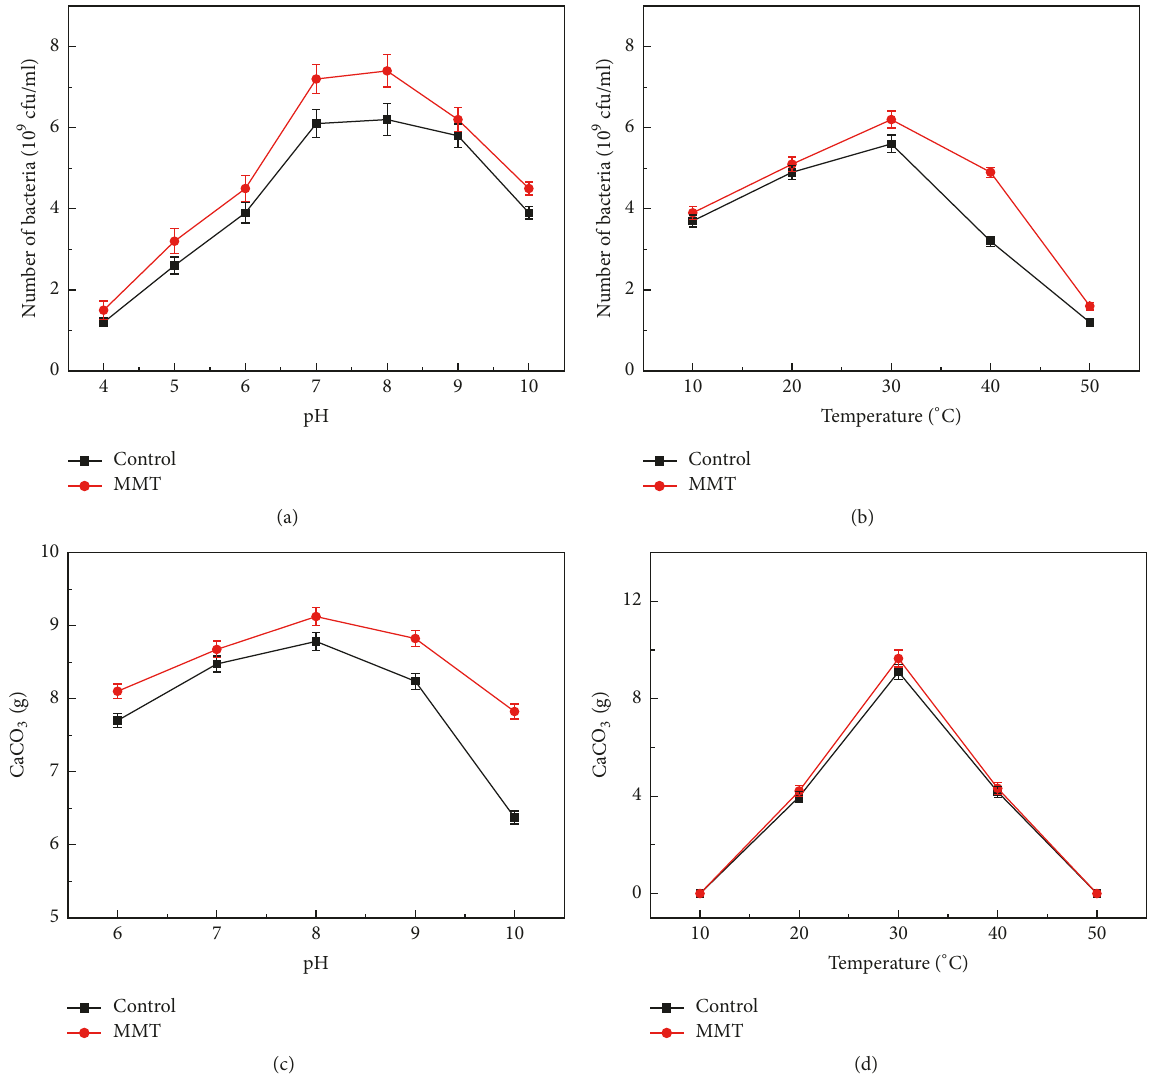
Figure 7: (a) Effect of pH on the growth of bacteria, (b) effects of temperature on the growth of bacteria, (c) effect of pH on the yield of CaCO 3 , and (d) effect of temperature on the yield of CaCO 3